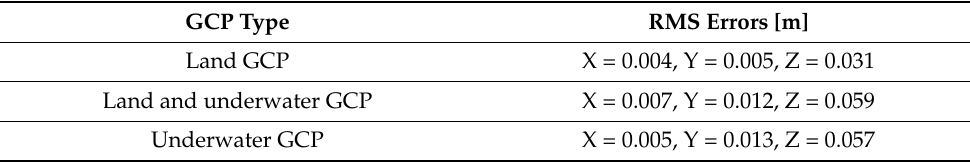
Table 2. GCP errors for two scenarios of photogrammetric data acquisition.